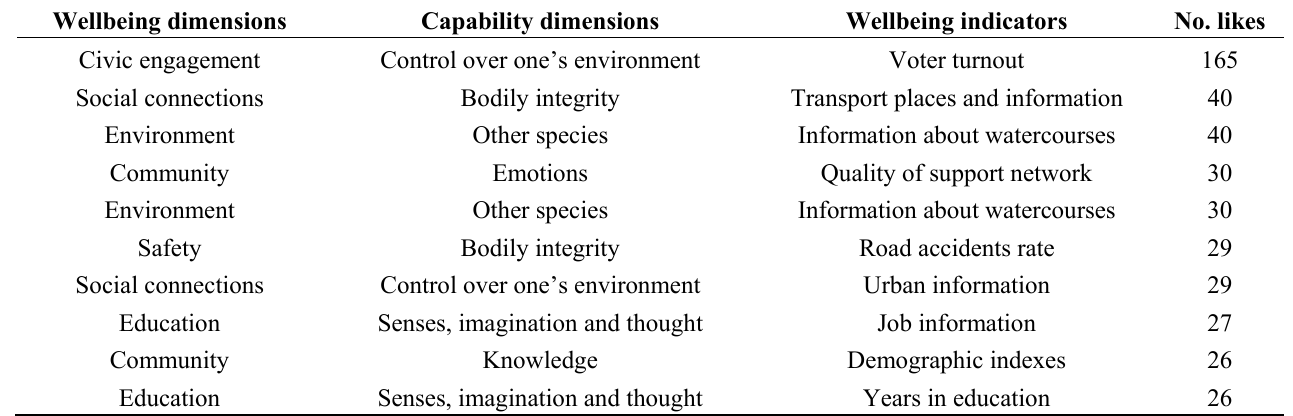
Table 4. “Likes” for the data sets of the “top ten” triples of capability-wellbeing dimensions and wellbeing indicators (Florence).